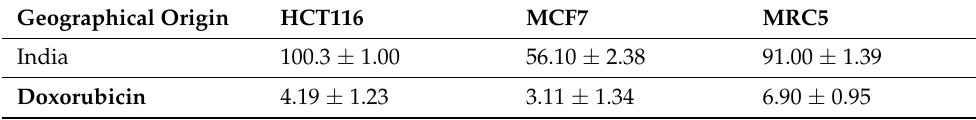
Table 2. Cytotoxicity and selectivity of the selected extract (MTT 48 h, IC 50 ± SD µ